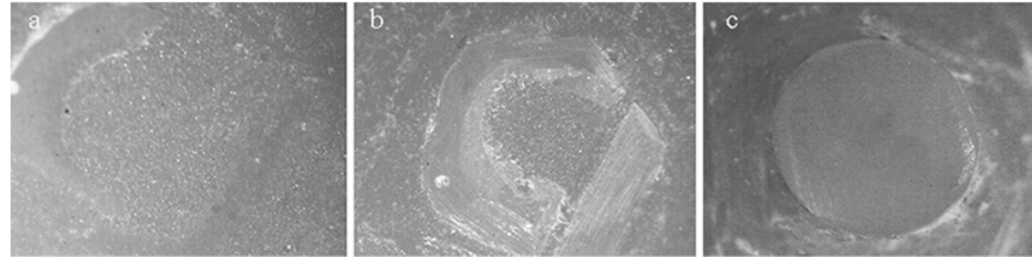
Figure 7. Stereomicroscope representative images showing ( a ) adhesive; ( b ) mixed; ( c ) cohesive failures of specimens subjected to microshear bond-strength test (40× magnification).